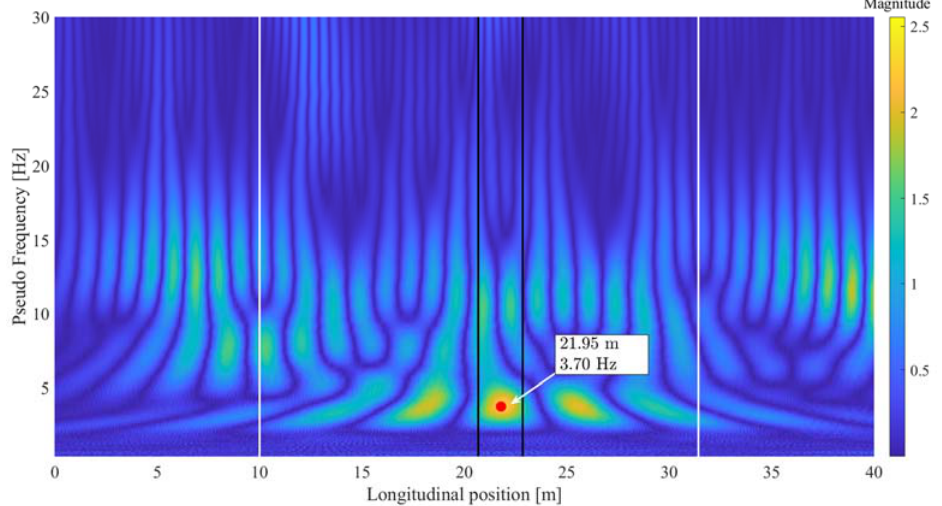
Figure 12. CWT damage detection results in the presence of different track irregularities in the healthy-bridge and damaged-bridge simulations and measuring noise.